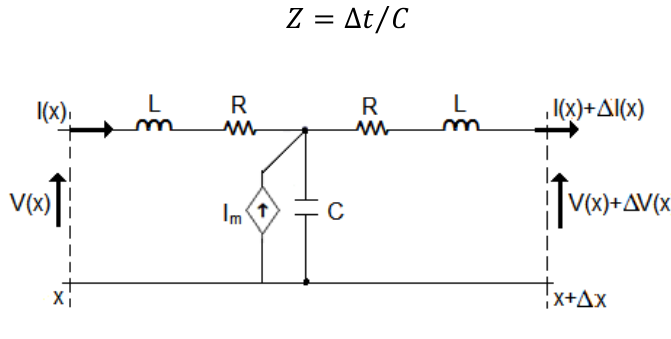
Figure 2. Electrical representation of TLM dispersion model.